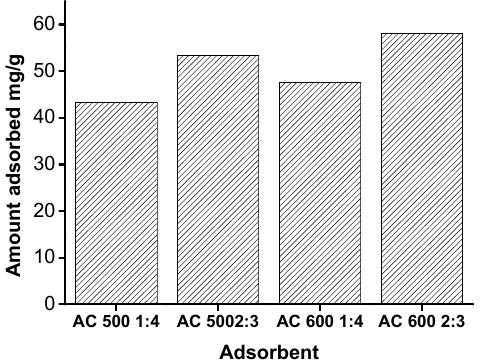
Figure 4. Pb(II) adsorption capacity of various carbon materials of AC-500 1:4, AC-500 2:3, AC-600 1:4, and AC-600 2:3 treated with 50 mg/L of Pb(II) (vol. = 200 mL; adsorption time = 2 h).